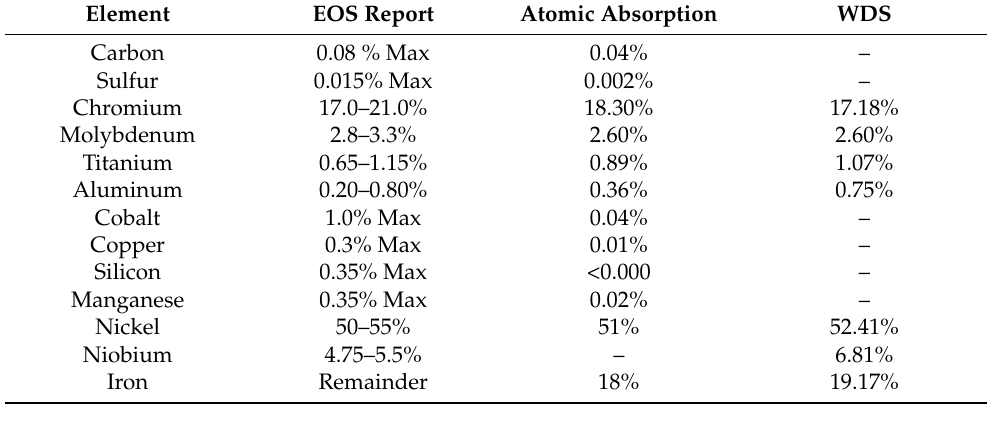
Table 1. IN718 powder composition obtained from different analysis methods.